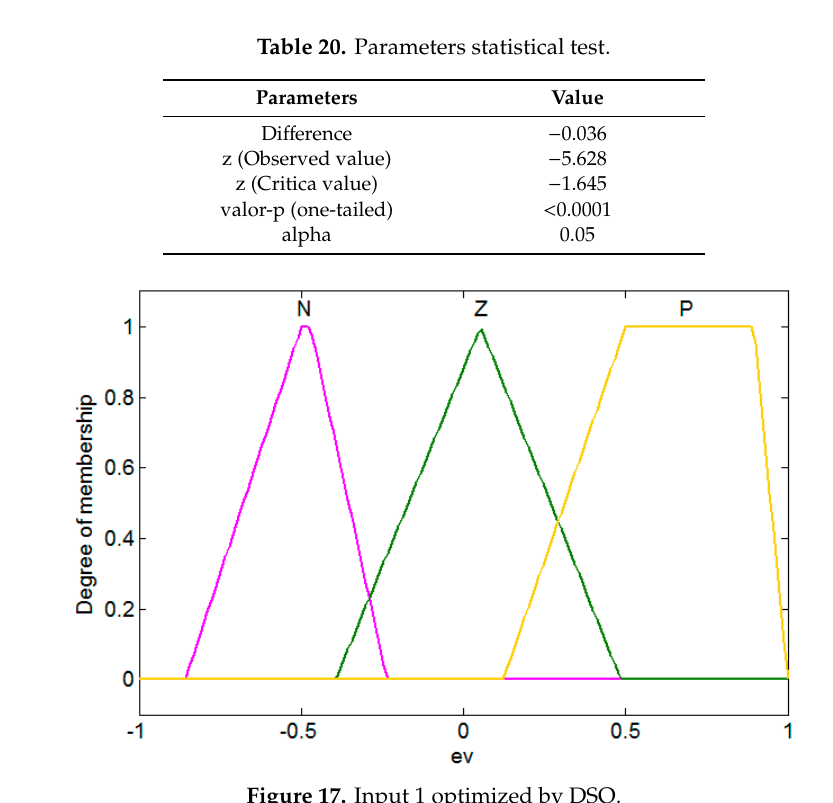
Figure 17. Input 1 optimized by DSO.